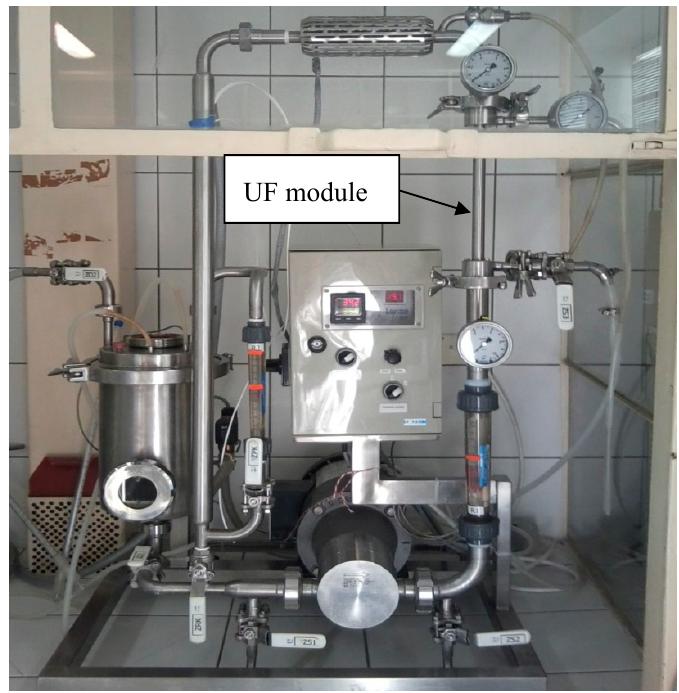
Figure 1. The photo of experimental ultrafiltration (UF) pilot-scale set-up.